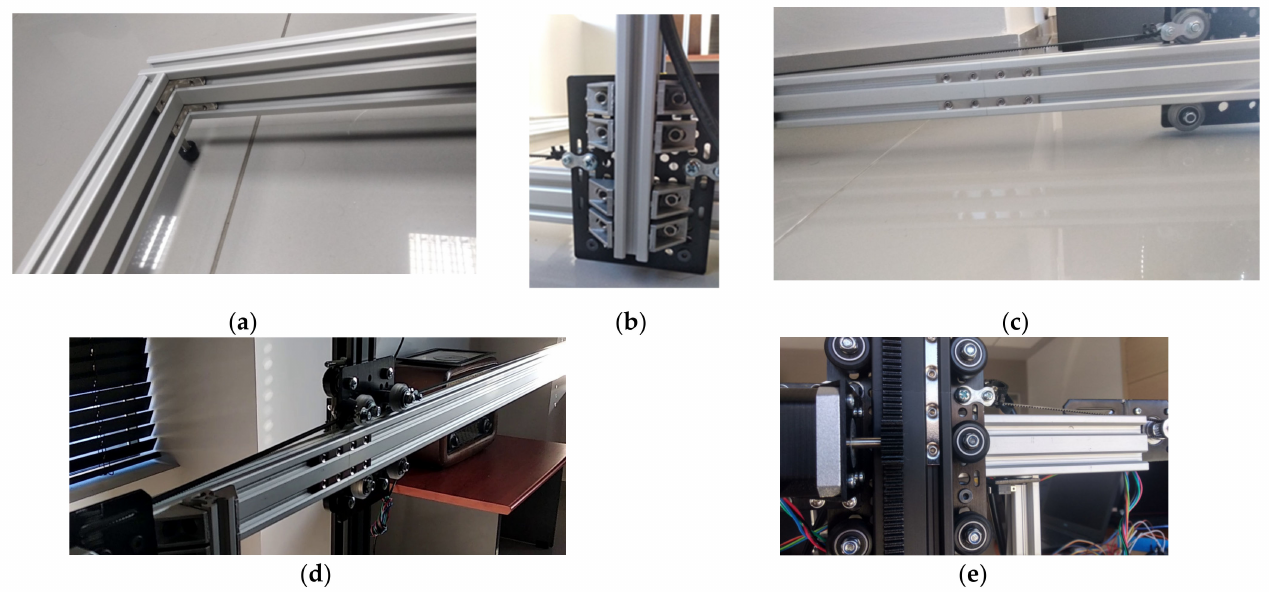
Figure 4. Details of the: ( a ) Frame’s inside hidden corner brackets; ( b ) V-Slot wagon and 90-degree corner brackets holding the Π frame ( c ) Frame’s quad connecting Tee Nuts for end to end V-Slot connections; ( d ) X axis layout and; ( e ) Z axis wagon and motor layout.